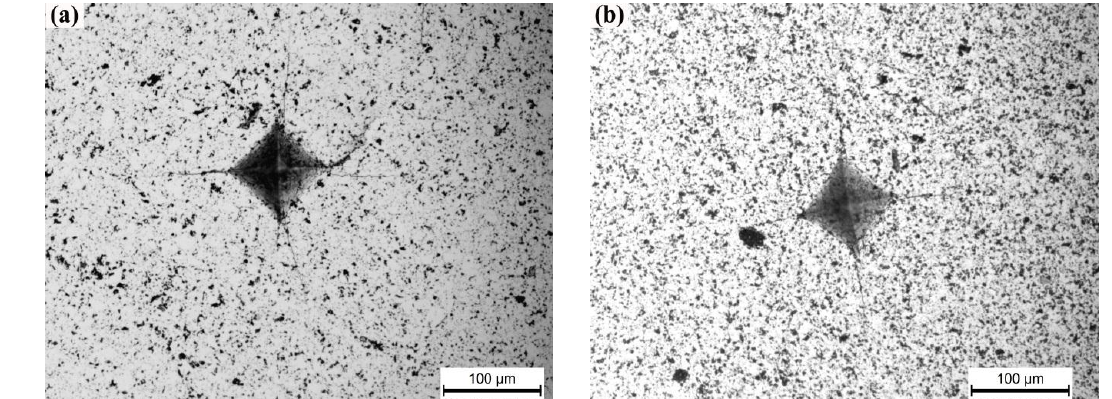
Figure 10. Micrographs of the Vickers hardness indents on the specimen sintered at ( a ) 1200 °C and ( b ) 1300 °C.